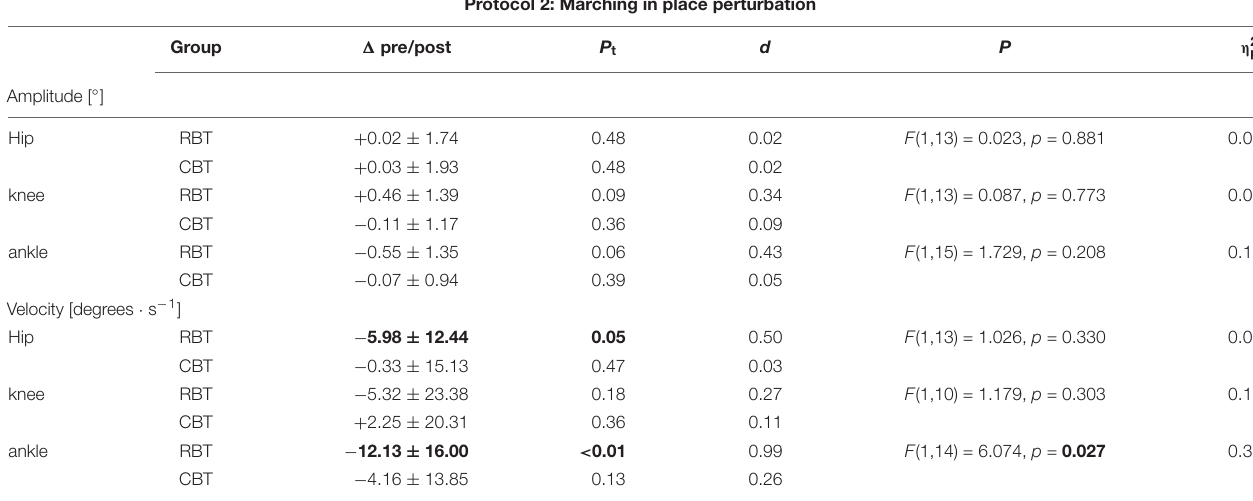
Protocol 2: Marching in place